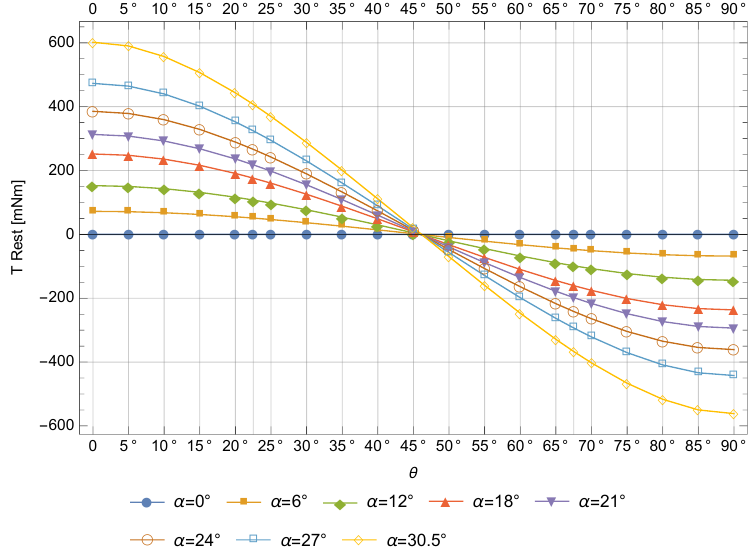
Figure 12. Restoring torque T Rest ( α , θ )